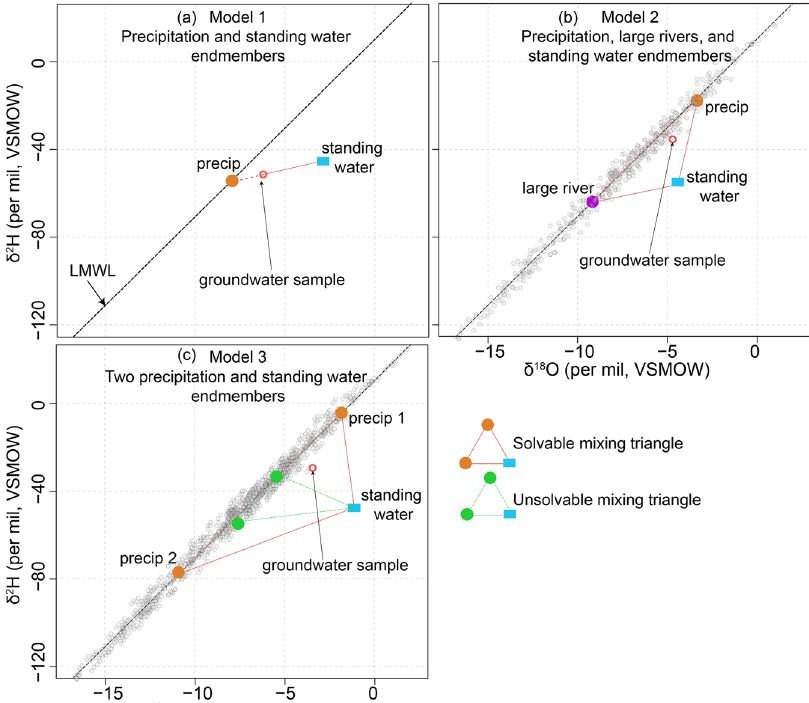
Fig. 5 Graphical illustration of the three mixing models. In model 1 ( a ), groundwater is modeled as a mixture of precipitation and standing water. The line joining the surface water endmember and the groundwater (solid red) is extended to join the LMWL (dashed red). The point of intersection is the precipitation endmember isotope ratio. In model 2 ( b ), groundwater is modeled as a mixture of precipitation, a large river, and standing water endmembers. The light gray circles are the 500 randomly generated precipitation isotope ratios. The red triangle connecting the large river (purple circle), standing water (blue rectangle), and precipitation (orange circle) endmembers illustrate one of the 500 possible triangles for each standing water sample. In the example shown here, the groundwater sample (open red circle) falls within the red triangle, and hence the mixing model is solvable. In model 3 ( c ), groundwater is modeled as a mixture of 2 precipitation endmembers and a standing water endmember. For each standing water endmember, we generate two random distributions of 500 precipitation isotope values and, from each of those distributions, chose the precipitation endmember values (orange and green circles). The red triangle connecting two orange circles (precipitation endmembers) and blue rectangle (standing water endmember) results in a solvable mixing triangle, i.e., groundwater isotope ratios can be modeled as a mixture of these three endmembers. The green triangle connecting two green circles (precipitation endmembers) and a blue rectangle (standing water endmember) results in an unsolvable mixing triangle, i.e., linear mixing between these endmember values cannot explain the observed groundwater isotope ratios. Fig. S4 shows the isotopic range of the respective